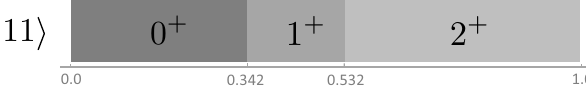
FIG. 8. Achievable fidelities with the two-mode target Fock state | 1 (cid:3) ⊗ | 1 (cid:3) . Note that the first value 0.342 is greater than the square of the maximum achievable fidelity with a single-photon Fock state: this means using a state of the form ˆ S (ξ 2 ) ˆ D (α 2 ) | 0 (cid:3) is not an optimal way to approximate the state | 1 (cid:3) ⊗ | 1 (cid:3) with a two-mode state of stellar rank 0. Similarly, the second value 0.532 is greater than the maximum